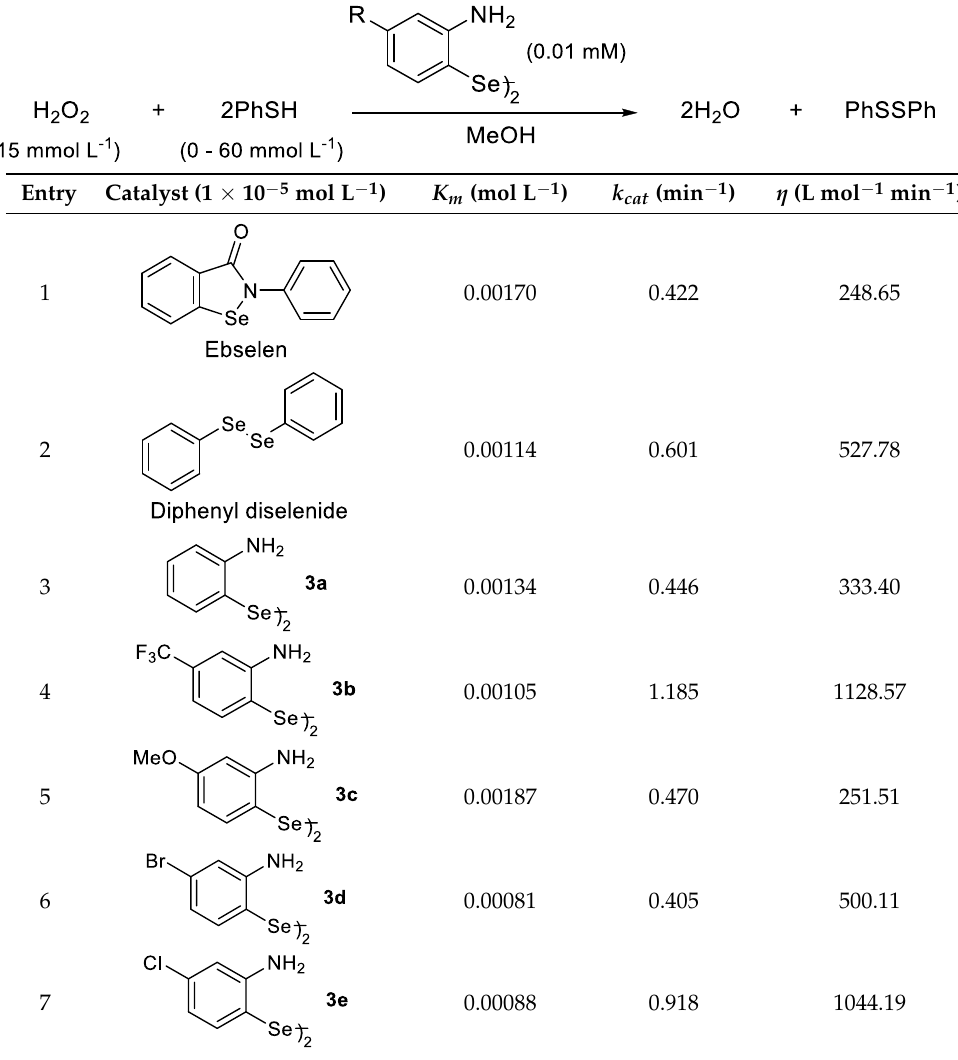
Table 1. GPx-like catalytic evaluation of aniline-derived diselenides 3a – e .